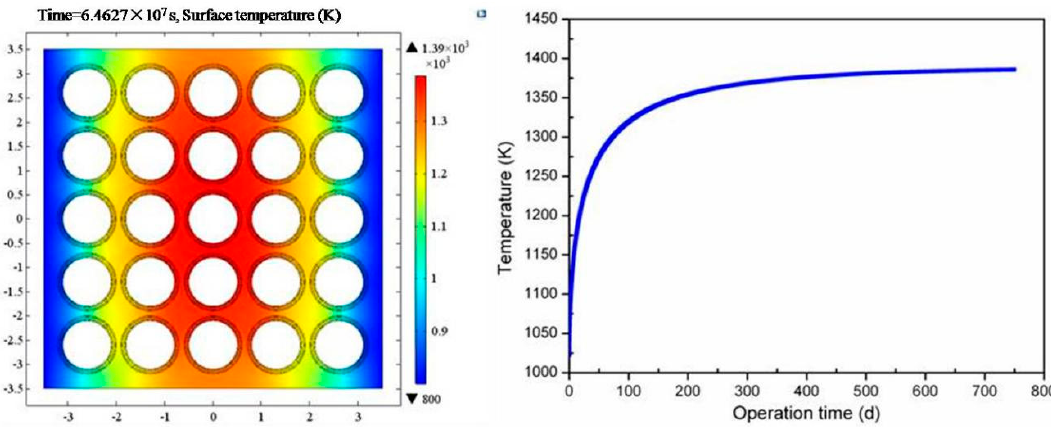
Figure 6. Matrix temperature profile at end of life (EOL) of FCM pellet and variation of the maximum matrix temperature with operation time.